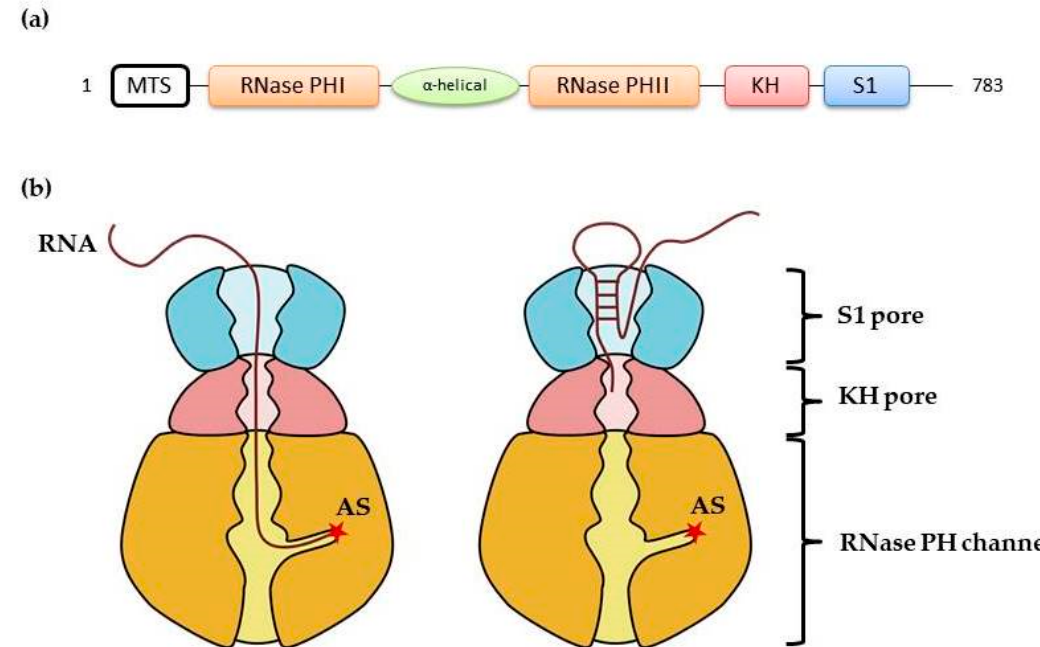
Figure 4. Human polynucleotide phosphorylase as an RNA import factor. ( a ) Domain organization of human PNPase. ( b ) Schematic model of a PNPase trimer bound to RNA. (Left) If the 3’ overhang is long enough, the bound RNA can access the active site (AS) and be degraded. (Right) Structured transcripts, e.g., imported small noncoding RNAs cannot enter the KH pore, which prevents their degradation [113,115] .